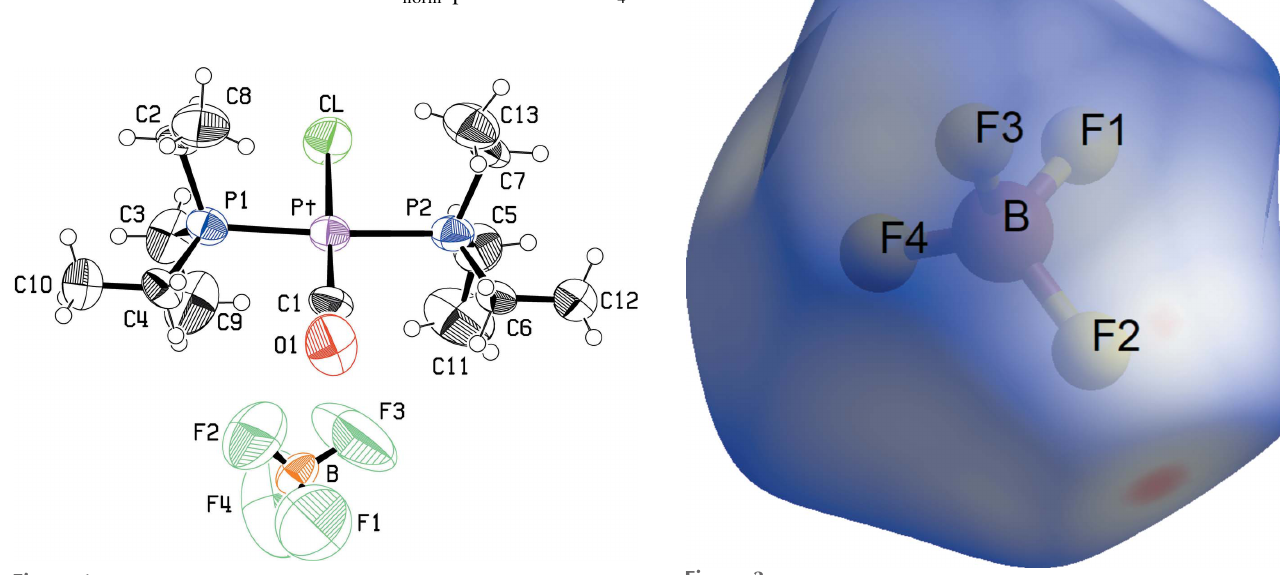
Figure 1 View of the molecular entities showing the atomic numbering and displacement ellipsoids at the 50% probability